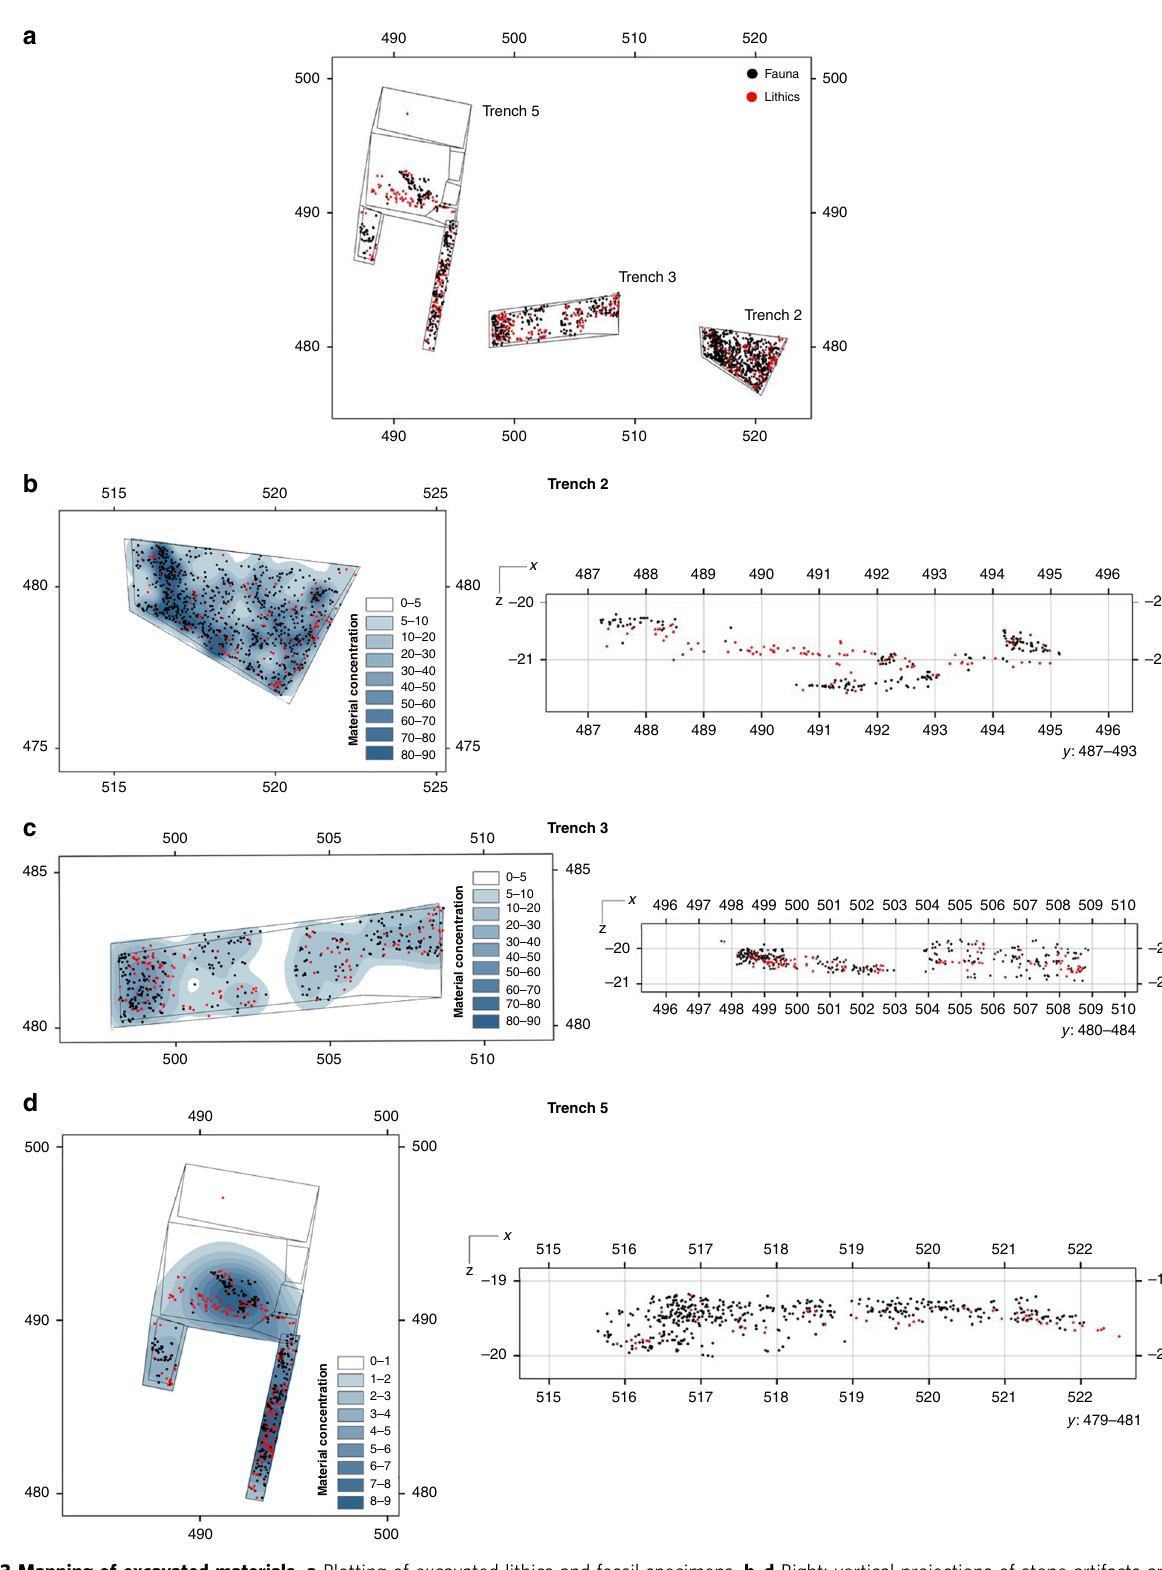
Fig. 3 Mapping of excavated materials. a Plotting of excavated lithics and fossil specimens. b – d Right: vertical projections of stone artifacts and bones show discrete archaeological horizons (axis units are in meters). Left: Kernel density analysis shows spatial variations in the accumulation of archaeological materials (densest in darkest blue). The stratigraphic position of trenches 2, 3, and 5 within the overall column is presented in Fig.